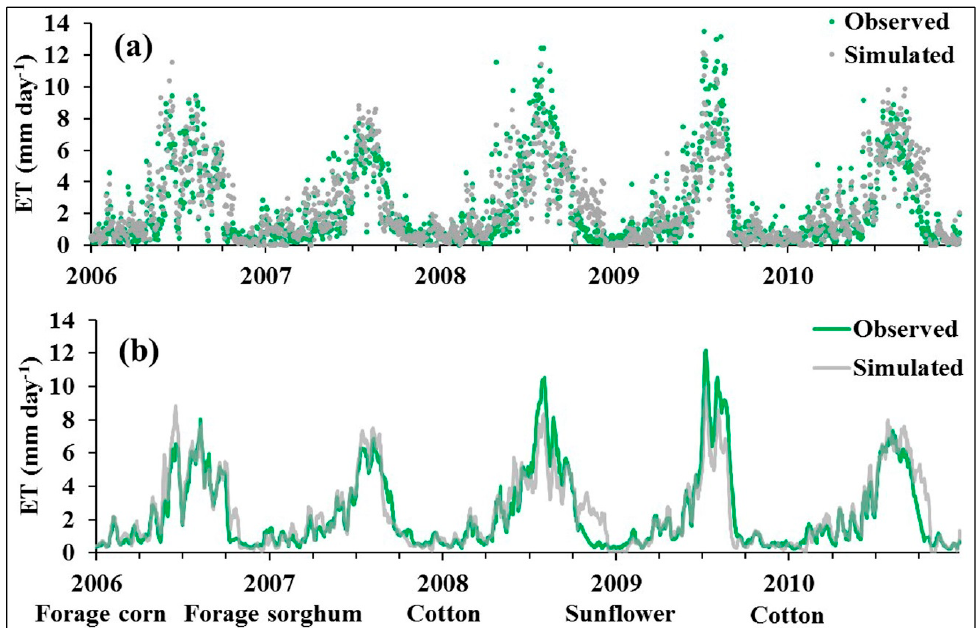
Figure 3. SWAT simulated daily ( a ) and seven-day running average ( b ) ET versus observed ET of the irrigated lysimeter field during the validation period (2006–2010).